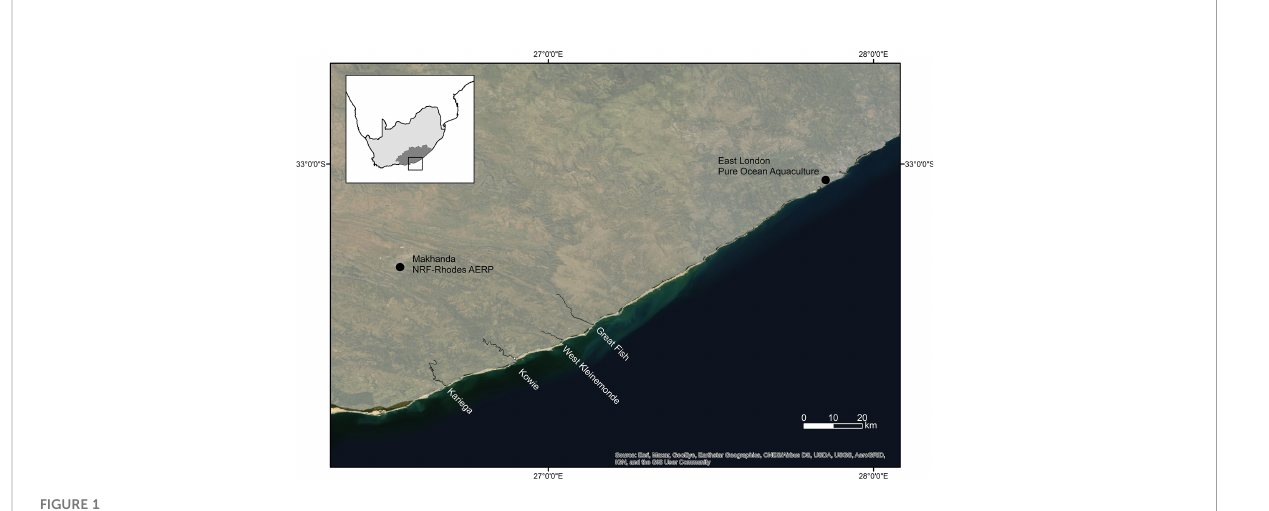
FIGURE 1 Map showing the study area and locations referred to in the text.